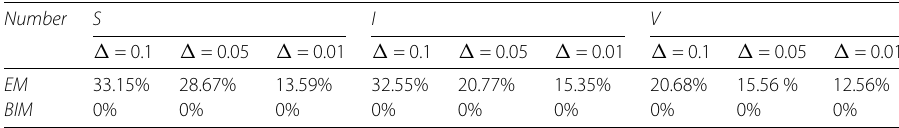
Table 1 Percentage of negative paths for the EM scheme and BIM